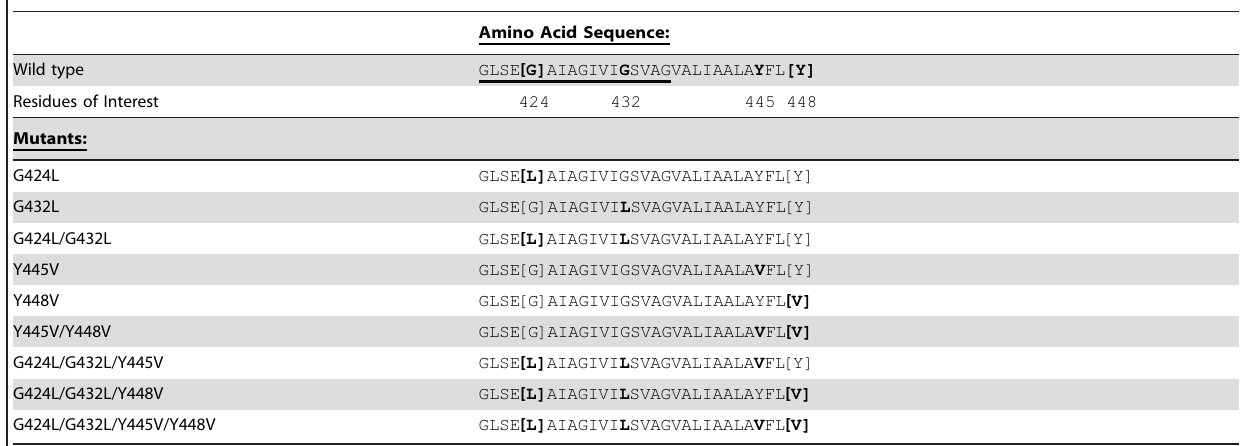
Table 2. CEACAM1-4s Transmembrane